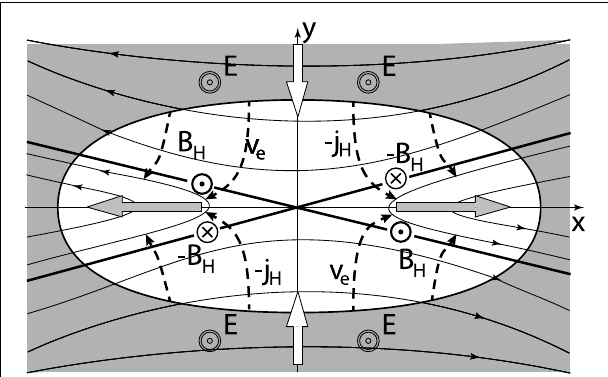
FIGURE 3 | Geometry of the Hall effect the X-line in collisionless reconnection. The white region is the domain r (cid:2) λ i from the X-line accounting for a potential asymmetry between the inflow and outflow direction which elongates the region into the outflow direction. Electron (dashed lines) performing an inward E × B-drift. Hall currents J H are centered on the separatrices forming four half-loops. They generate the quadrupolar Hall magnetic field B H . Open arrows show the inflow at low speed V in and the outflow at high speed V out . The convection electric field points out of the plane. Ions are accelerated in this field out of the plane thereby contributing to the sheet current. This contribution effectively causes a broadening of the current